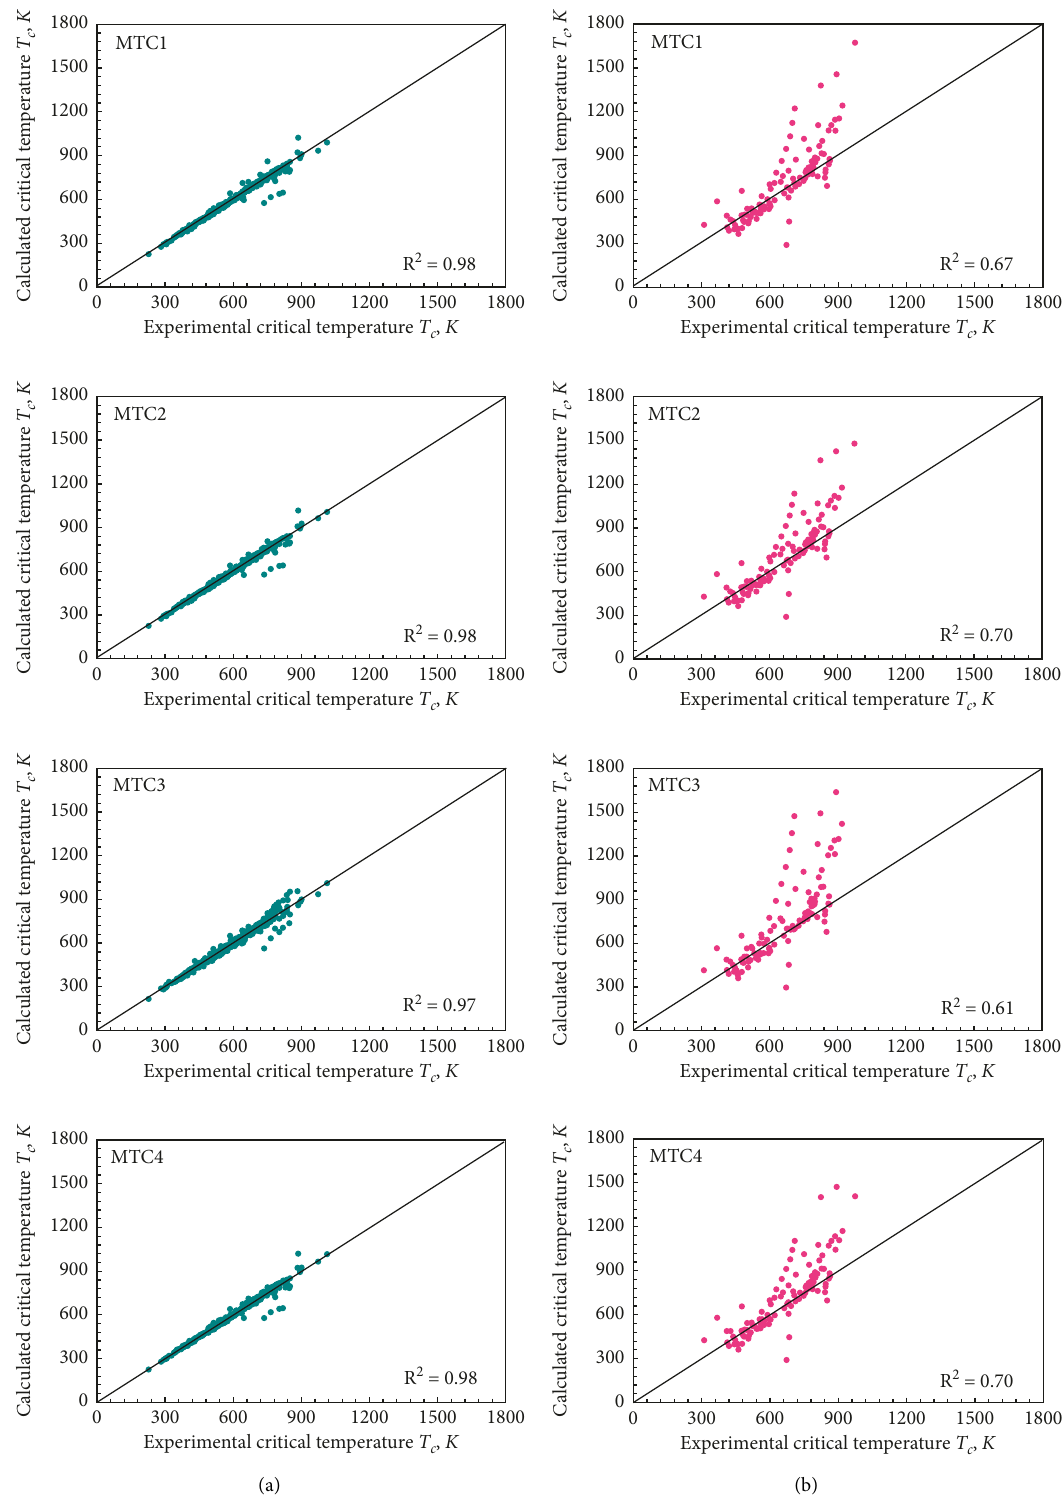
Figure 3: Results of the calculation of the critical temperature of pure compounds using different first-order GCMs. (a) Correlation and (b)